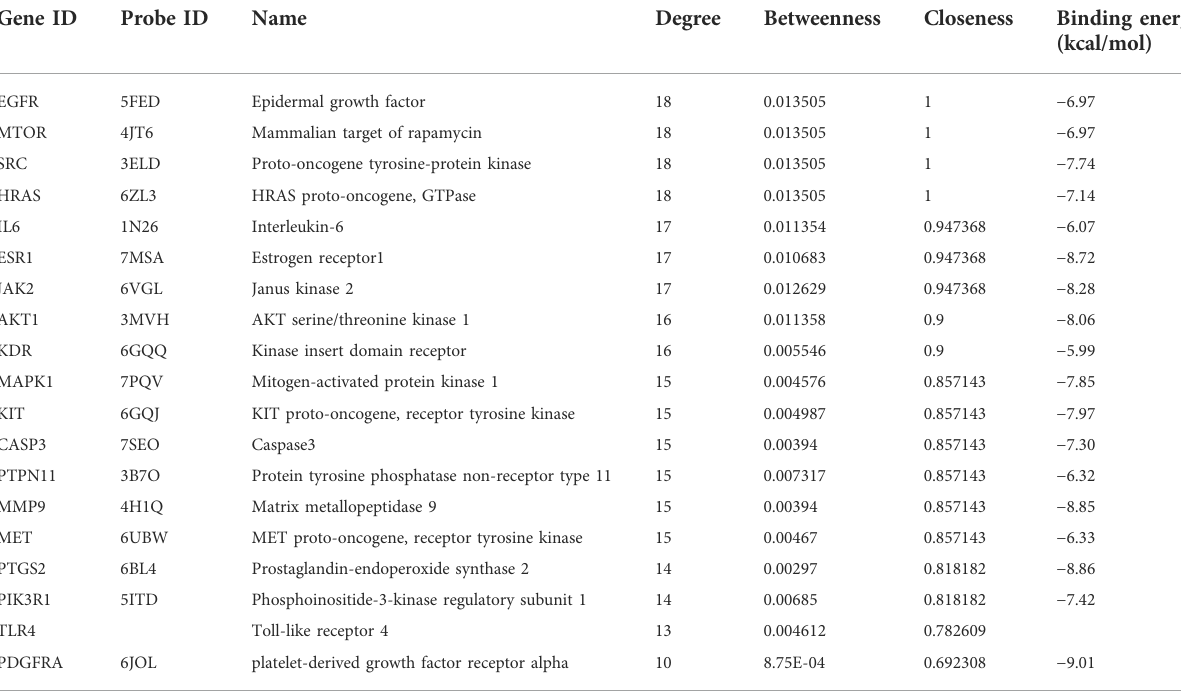
TABLE 1 Degree, betweenness, closeness, and binding energy values of 19 hub